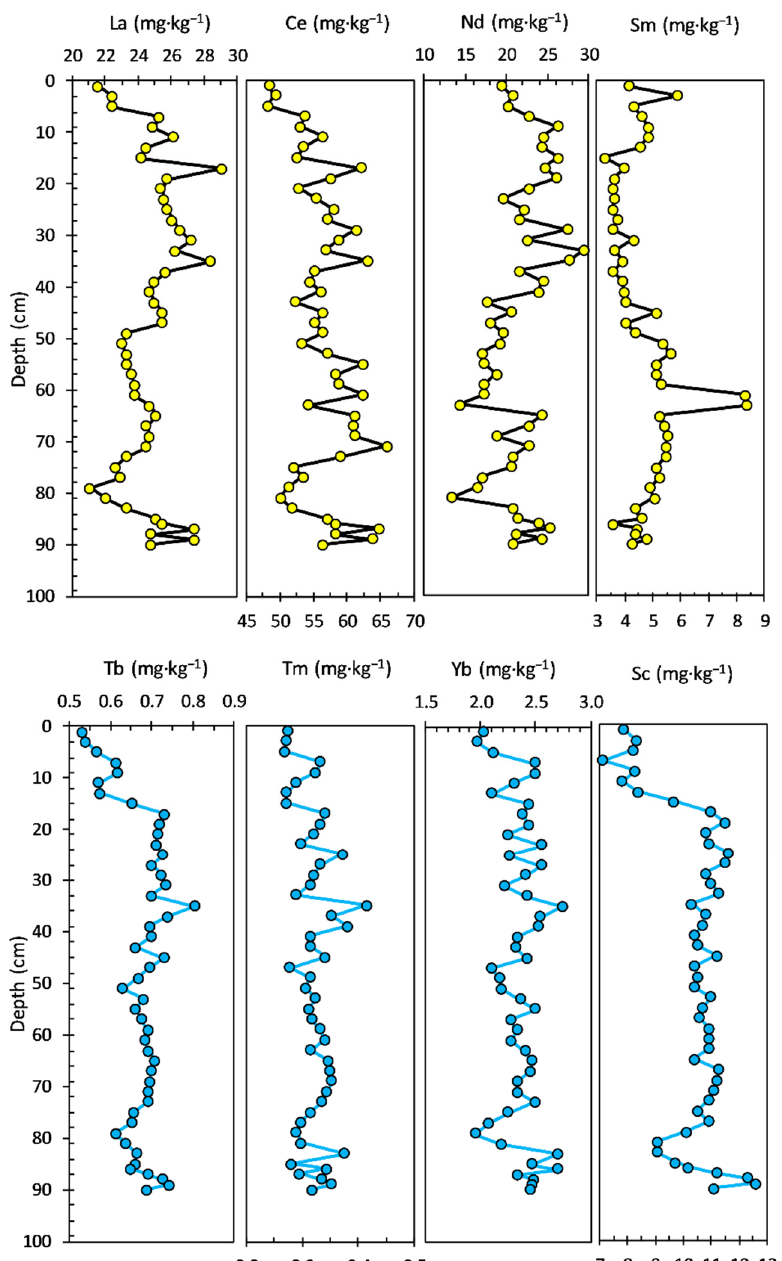
Figure 12. Vertical distribution of geochemical light rare earth elements—LREE (La, Ce, Nd, Sm) and heavy rare earth elements—HREE (Tb, Tm, Yb, Sc) in the Movila Miresii Lake sediment core (90 cm